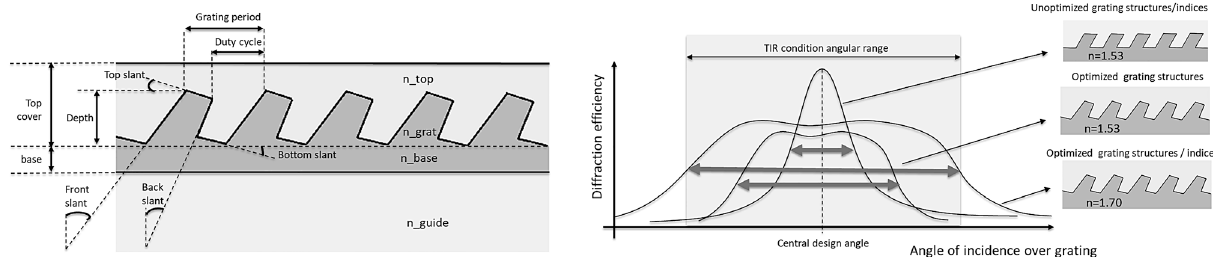
Figure 20: Optimizing the grating parameters to optimize color uniformity over the FOV.